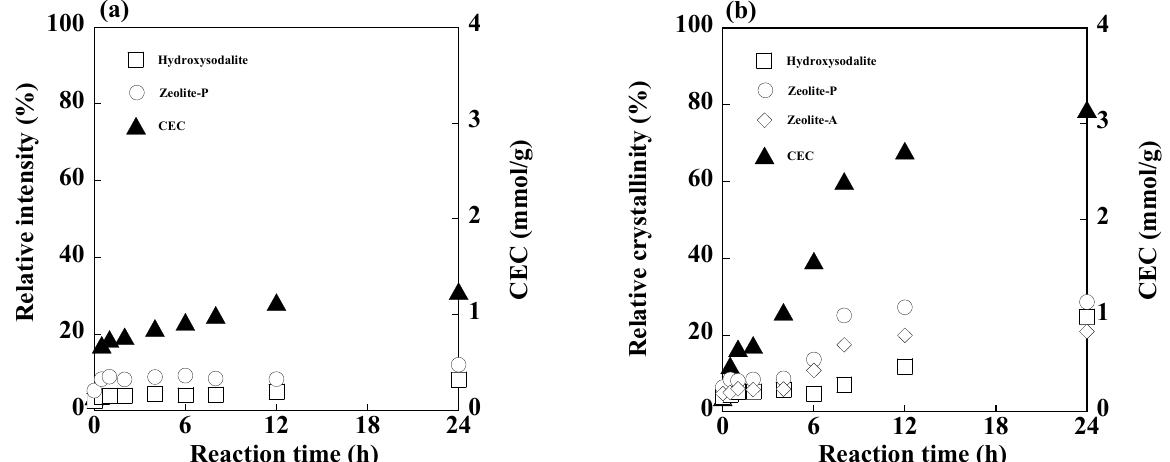
Figure 10. Relative crystallinities of the product phases in the product, and CECs of the product during synthesis at 80 ◦ C: ( a ) without 1 M EDTA and ( b ) with 1 M EDTA (NaOH concentration: 3 M